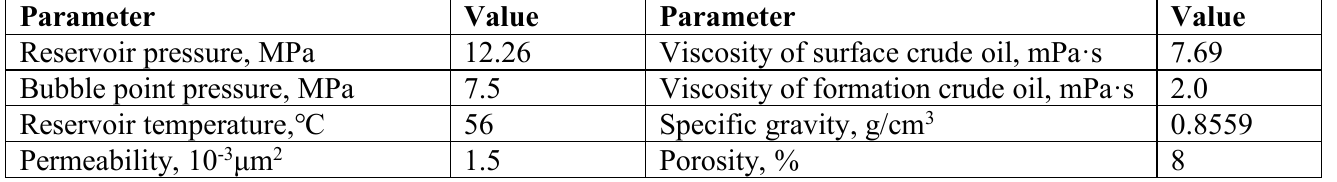
Table 1—Main reservoir properties of the target